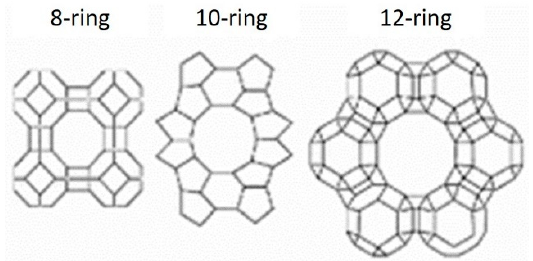
Figure 6. Schematic of “n” rings that are frequently found in the zeolite framework. Reprinted from Reference [75], with permission from Springer nature.